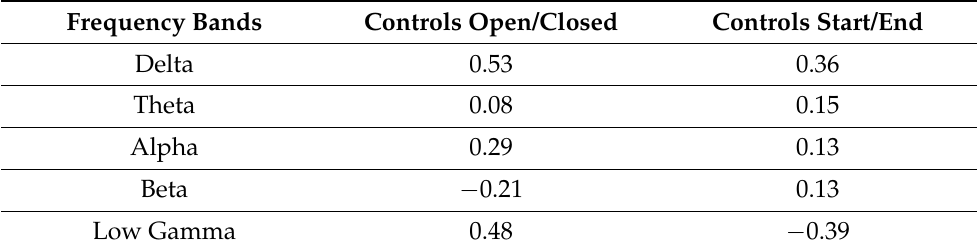
Table 2. Maximum node degree ICC (Max. ND